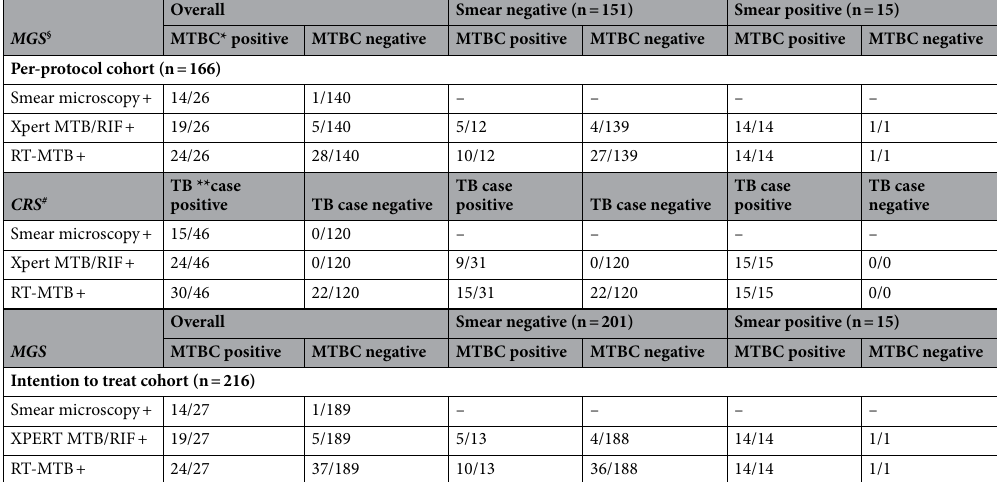
Table 2. Absolute test results for the per-protocol cohort (n = 166) for the intention-to-treat cohort (n = 216). * MTBC Mycobacterium tuberculosis complex; ** TB tuberculosis; § MGS microbiological gold standard (results on aggregated culture), # CRS composite reference standards (by combining microbiological results and clinical information on treatment